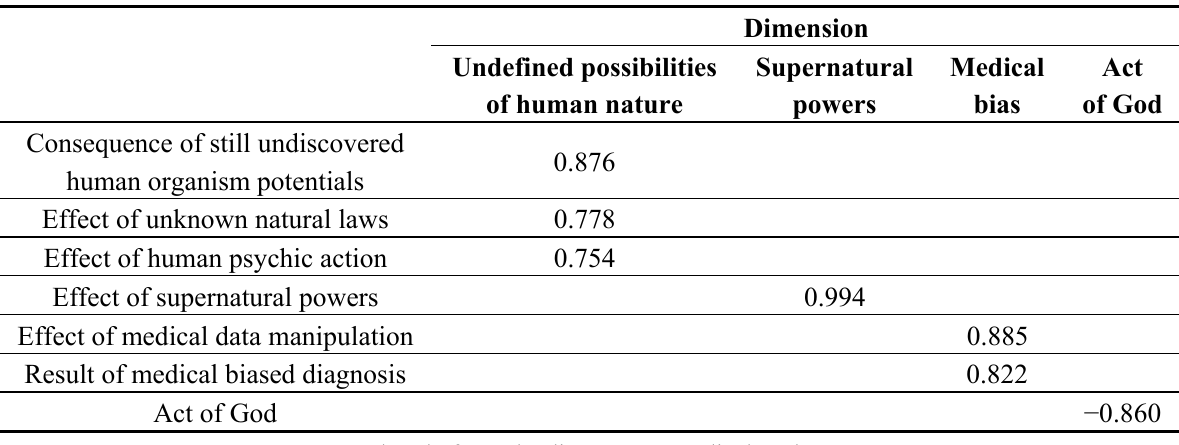
Table 1. Results of the factor analysis for the Beliefs about Miraculous Healings Scale (BMHS)